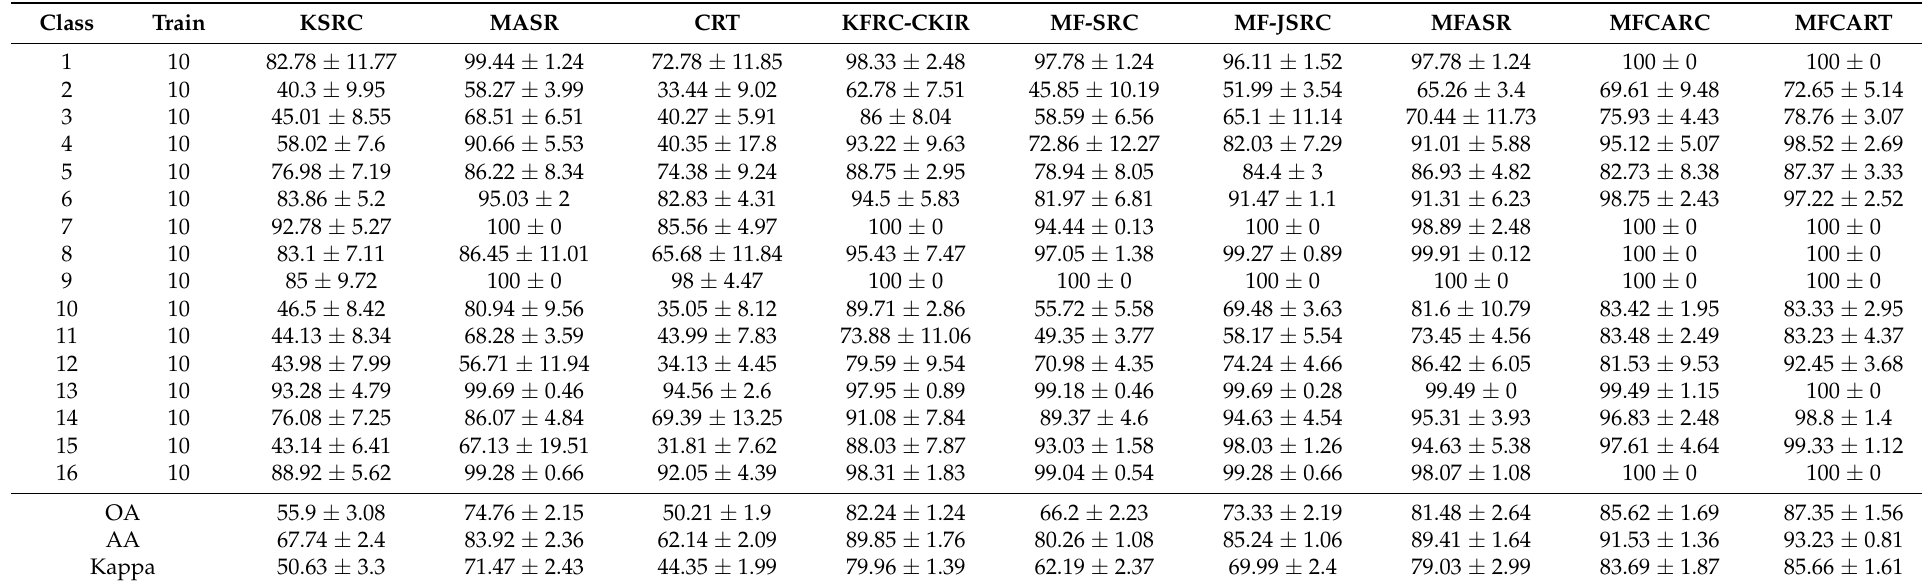
Table 7. Classification accuracy (%) of different classifiers for the Indian Pines data